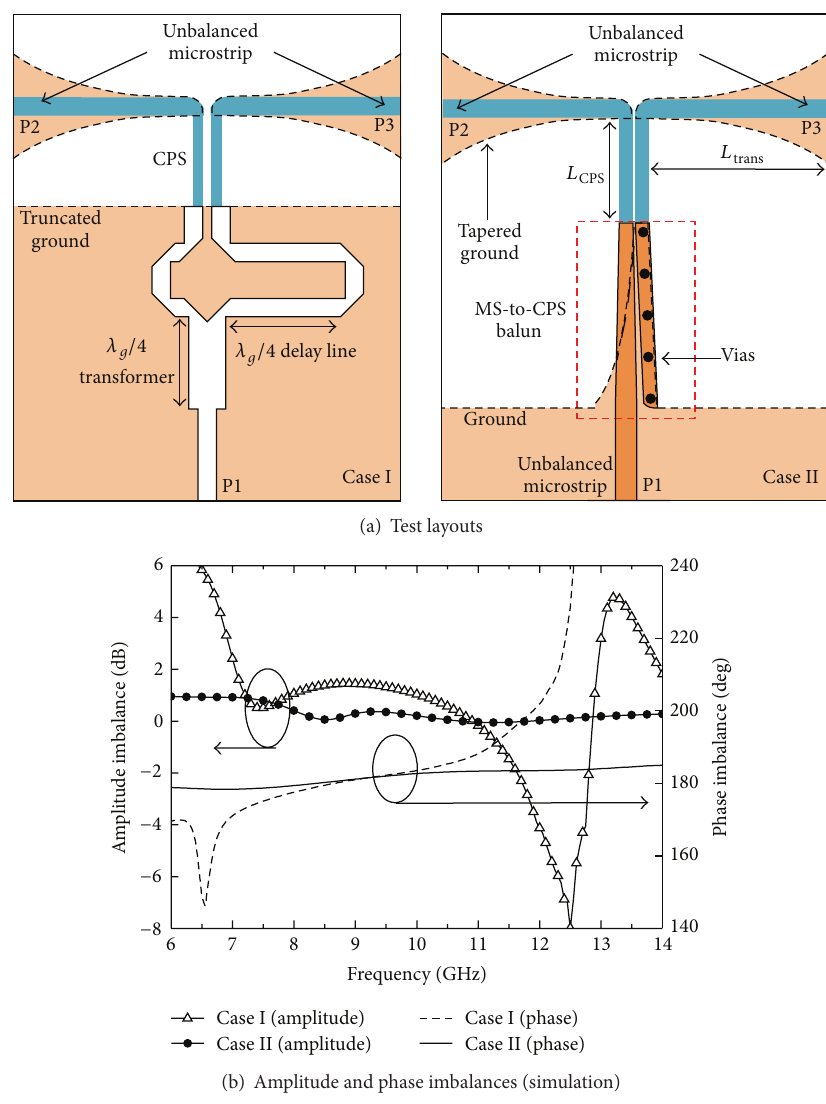
Figure 4: Balance analysis of MS-to-CPS